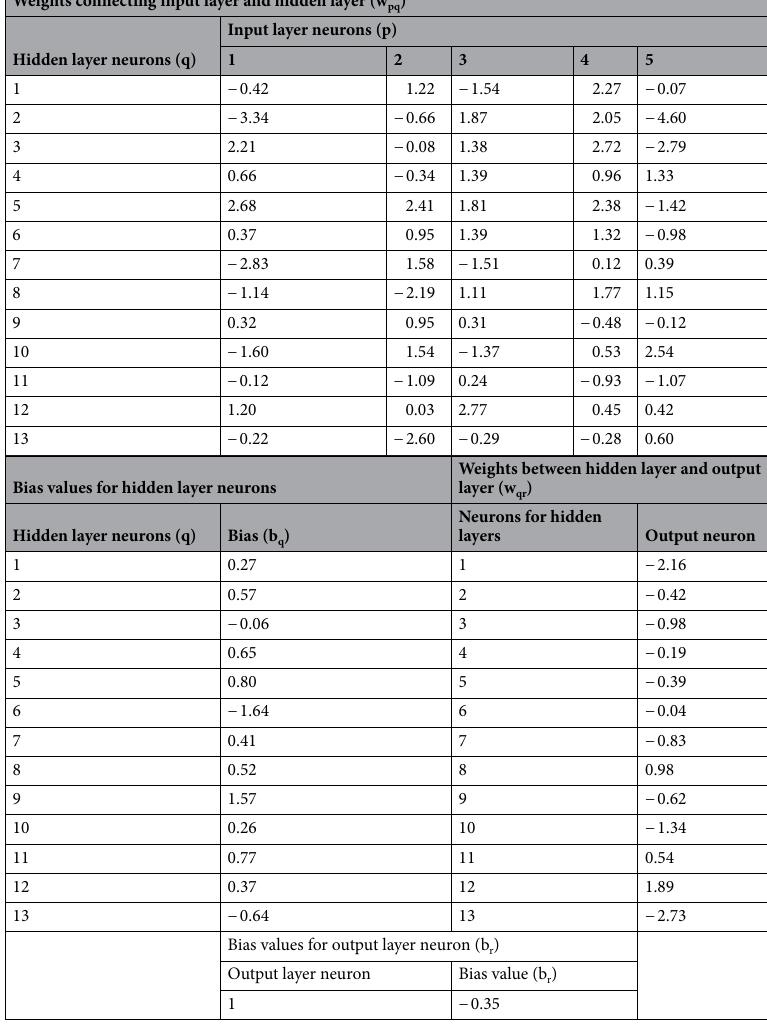
Table 3. Biases and weights connecting the input, hidden, and output layers of ANN